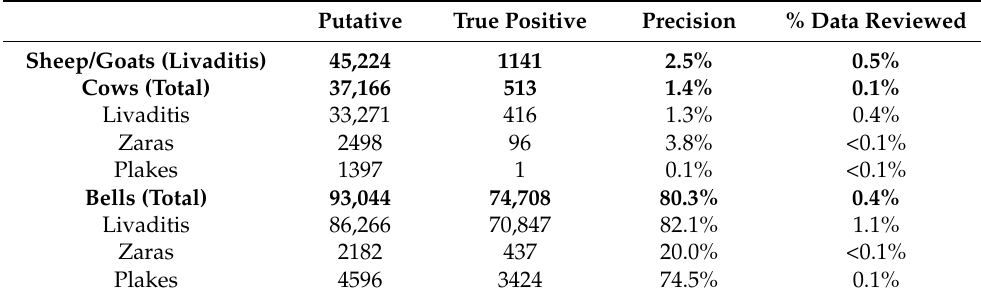
Table 3. Number of identified putative livestock calls/bells flagged by the detection algorithms for each site, true positive events among them, % precision as confirmed by the human listener, and % of total acoustic dataset that had to be reviewed manually. Bold rows denote total count or mean % per call